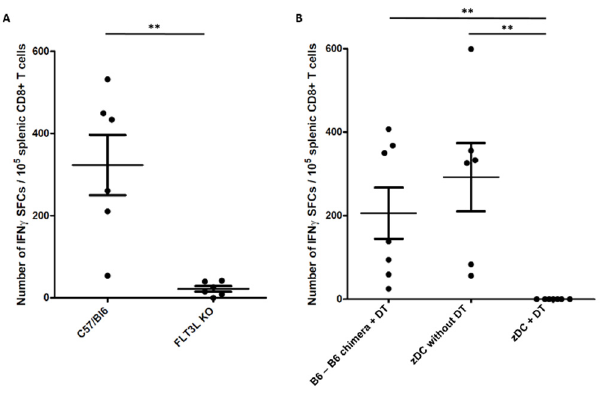
Figure 2. Conventional dendritic cells (cDCs) are required for immune response to melanin-based vaccines. ( A , B ) ELISpot analysis of splenocytes from the indicated mouse strain, 7 days after im- munization with [gp100-Mel + CpG] vaccine. ( B ) B6-B6 chimera treated with DT and zDC-B6 not exposed to DT represent positive control. Data are presented as the normalized number of IFN γ spot forming cells (SFCs) per 10 5 CD8 + T cells, based on flow cytometry analysis. Each point represents an individual mouse (pooled data from three independent experiments). Bars = mean values ± SEM. ** p < 0.01.